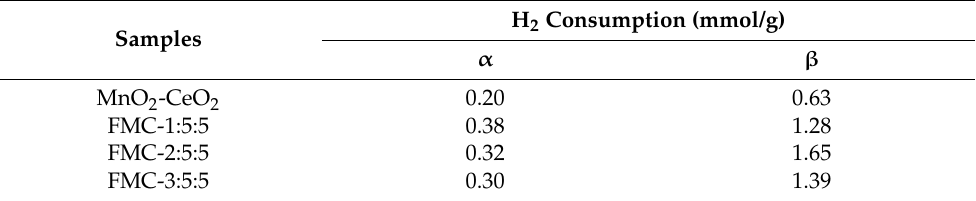
Figure 5. H 2 - TPR profiles of (a) FMC-1:5:5, (b) FMC-2:5:5 and (c) FMC-3:5:5. α refers to the reduction peak at 250–350 °C; β refers to the reduction peak at 350–450 °C. Table 2. Hydrogen consumption of FMC samples with different ratios of Fe/Mn/Ce.